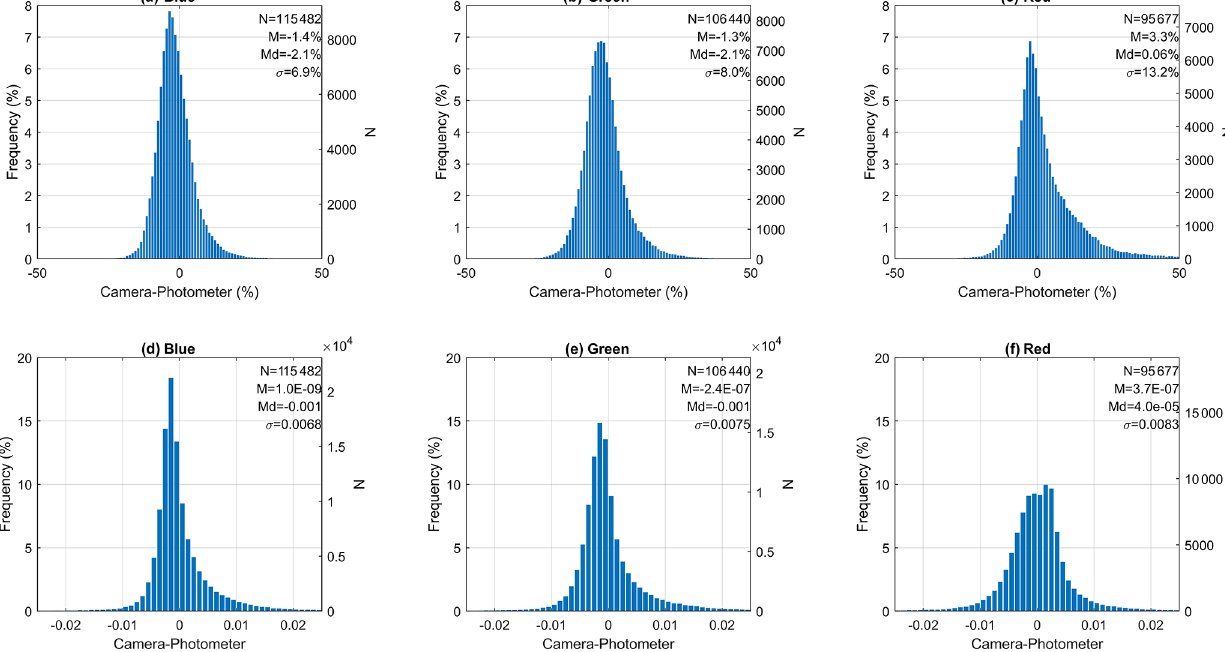
Figure 11. Frequency histograms of the relative (a–c) and absolute (d–f) differences between the camera and photometer normalized sky radiances for blue (a, d) , green (b, e) and red (c, f) channels, respectively. Radiances with scattering angles below 10 ◦ are not considered. The amount of data ( N ), the mean ( M ), median (Md) and standard deviation ( σ ) of the differences are also included.